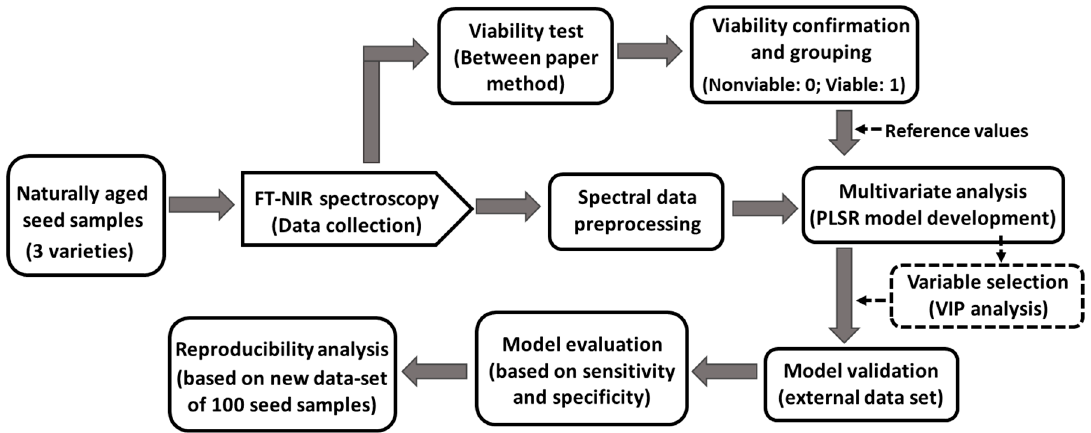
Figure 1. Procedure used to generate the generalized classification model using FT-NIR spectroscopic Procedure used to generate the generalized classification model using FT-NIR technique. spectroscopic